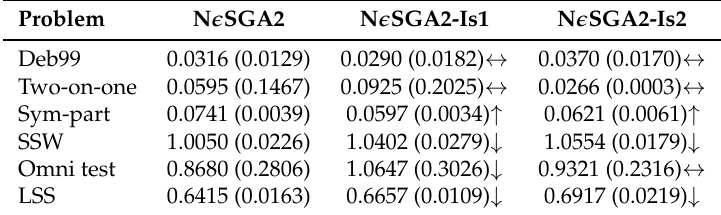
Table 4. Averaged ∆ 2 for the algorithms that use subpopulations and the base case in decision space.